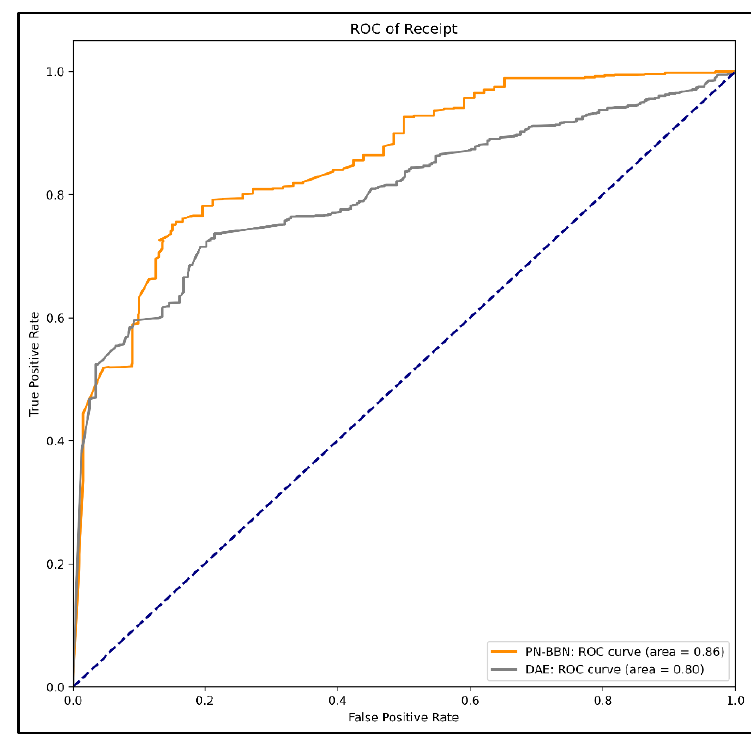
Figure 13. ROC of Receipt.